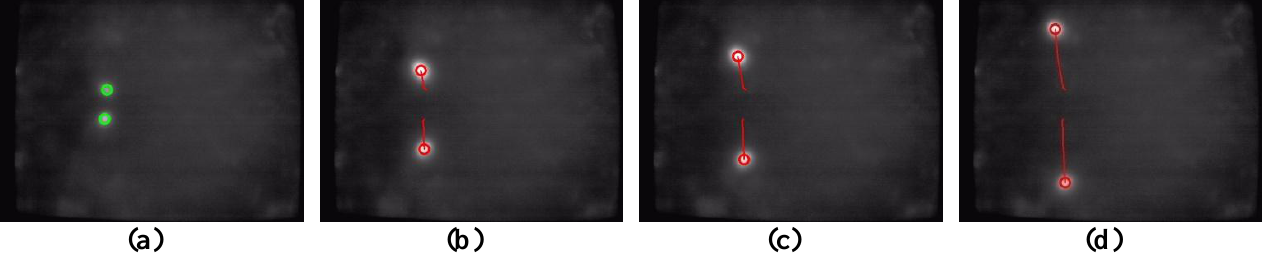
Figure 12. Touch finger detection and tracking results of the proposed system in Test sequence 2. (a) 187 th frame. (b) 193 rd frame. (c) 195 th frame. (d) 200 th frame. (e) 479 th frame. (f) 486 th frame. (g) 493 rd frame. (h) 503 rd frame. (i) 1607 th frame. (j) 1615 th frame. (k) 1625 th frame. (l) 1645 th